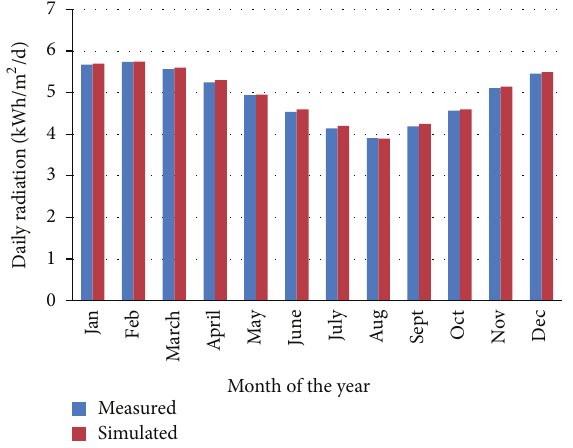
Figure 3: Calibrated solar